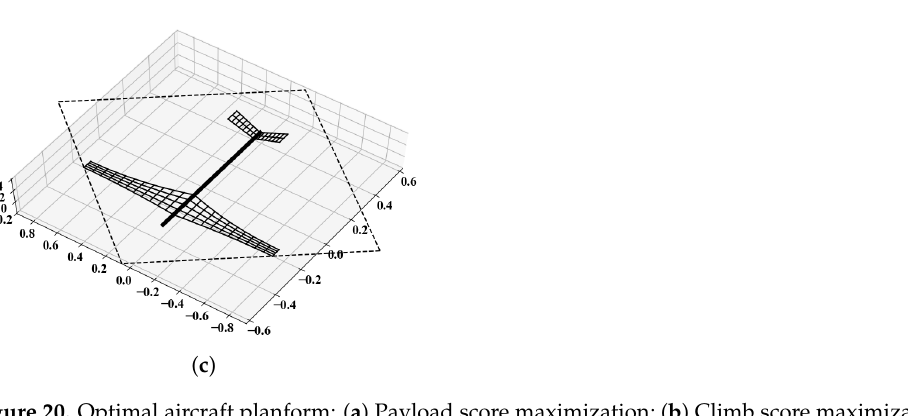
Figure 20. Optimal aircraft planform: ( a ) Payload score maximization; ( b ) Climb score maximization; ( c ) Distance score maximization.